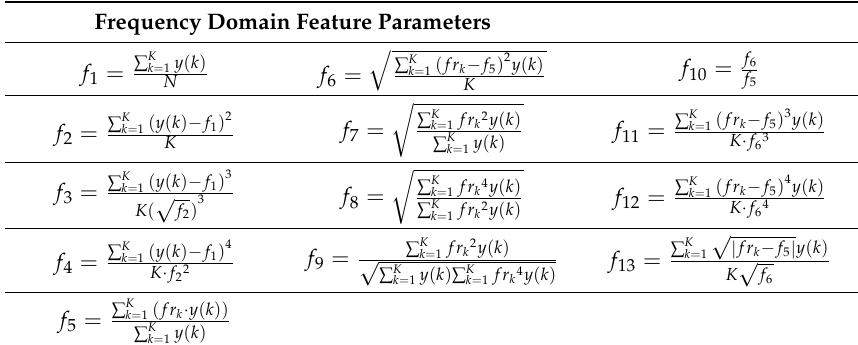
Table 2. Features in the frequency